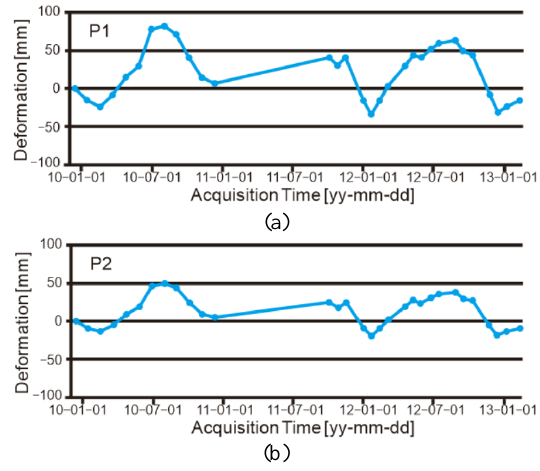
Figure 5. Deformation time series of PS points P1 and P2 due to thermal expansion, are indicated by white crosses located in two skyscrapers (a) SWFC and (b) Jin Mao Tower in Shanghai Lujiazui